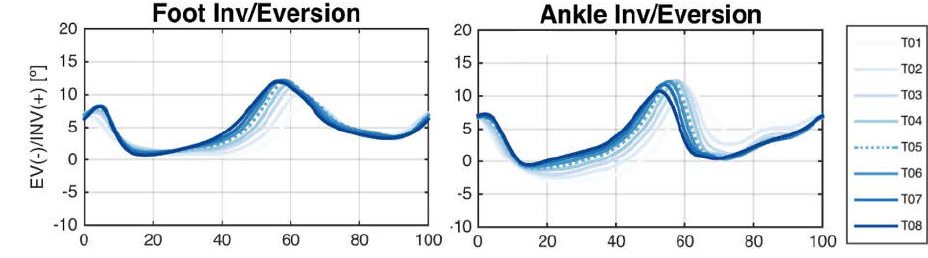
Fig. 7 Single sample data